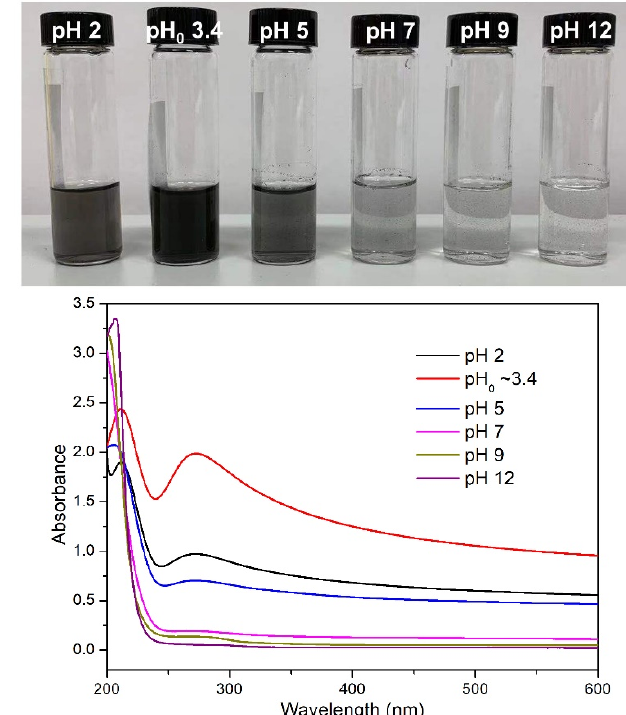
Figure 6. Photographs ( a ) and UV-vis spectra ( b ) of PAA100/rGO with different pH values. Conversely, BPEI is a cationic hydrophilic PE bearing primary, secondary, and tertiary amines, and carbon spacers. Based on the positively charged amines, an attractive electrostatic force between BPEI and the rGO surface is expected [45]. Being classified as a weak PE, the charge density of BPEI can also be tuned by the pH. Indeed, its protonation degree increases gradually from 0 at pH 12 to 1 at pH 2, with three pKa values for primary, secondary, and tertiary amines calculated as 4.5, 6.7, and 11.6, respectively [47,81]. In order to evaluate the adsorption behavior of BPEI with respect to rGO, a series of BPEI25 solutions with different pH values, from pH 4 to pH 12, were used to prepare BPEI/rGO dispersions (Figure 7). With decreasing degree of protonation, i.e., by increasing the pH, it was possible to note that the concentration of rGO increased by moving from pH 4 to 10 and then dropped in the 10 to 12 pH region. The uncharged BPEI solution (pH 12) revealed better rGO dispersion performances with respect to that of solutions characterized by an ionization degree α higher than 0.4 (pH ≤ 8). These results are in contrast to our previous hypothesis that BPEI and rGO interactions were mainly electrostatic in nature. However, these results are in agreement with a previous study describing the adsorption of BPEI on uncharged graphite [82]. Indeed, the adsorption process of BPEI onto graphite could be divided into three steps: diffusion toward the surface, adhesion to the surface, and rearrangement [82]. Step two plays an important role in dispersing and stabilizing